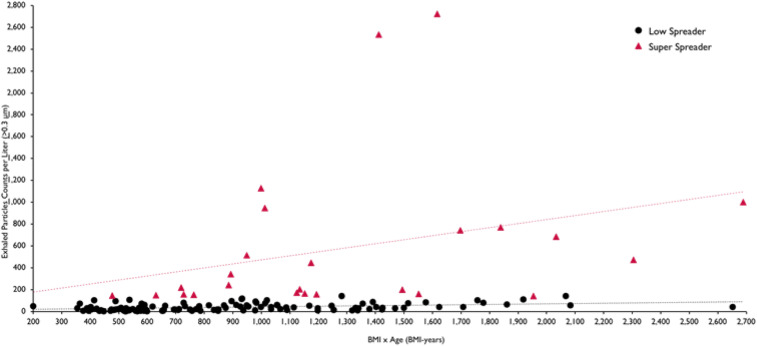
Exhaled breath particles as a function of BMI-years for volunteers reporting age and BMI (n = 146). Results of linear regression analysis are shown for the exhaled aerosol numbers from the superspreader and low spreader (of aerosol particles) subjects showing significant correlation, particularly for the superspreader subjects (r2 = 0.98).